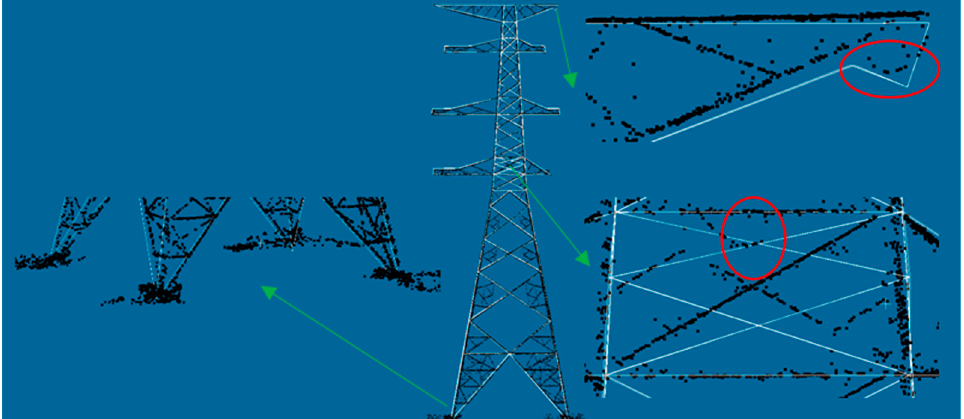
Figure 26. The result of pylon reconstruction after type 1 noise removed.